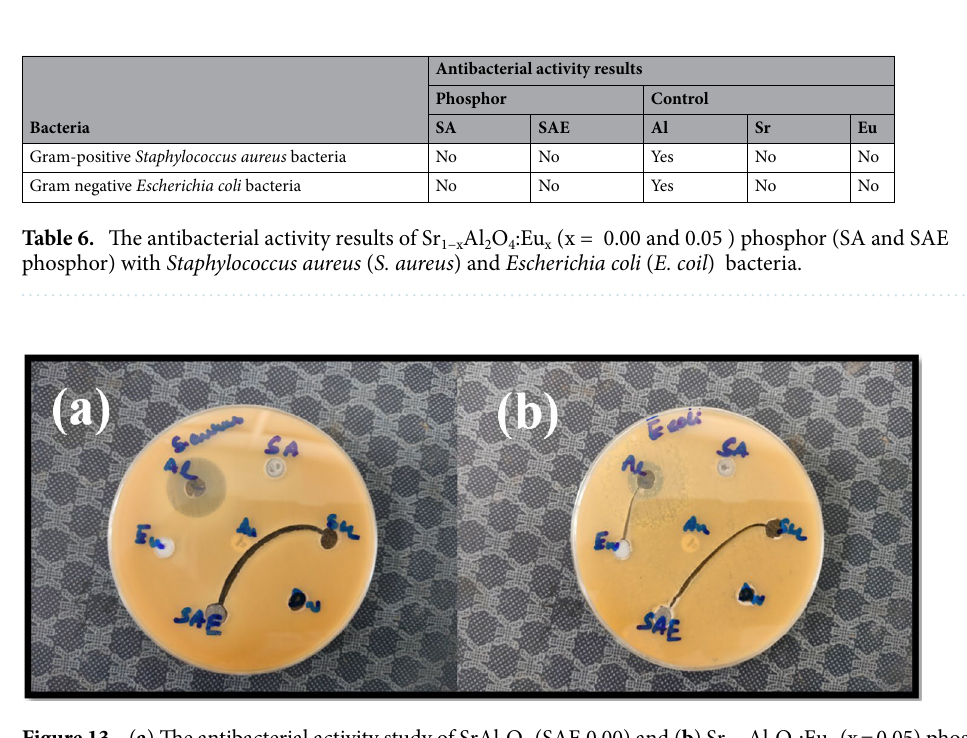
Figure 13. ( a ) The antibacterial activity study of SrAl 2 O 4 (SAE 0.00) and ( b ) Sr 1−x Al 2 O 4 :Eu x (x = 0.05) phosphor (SAE 0.05